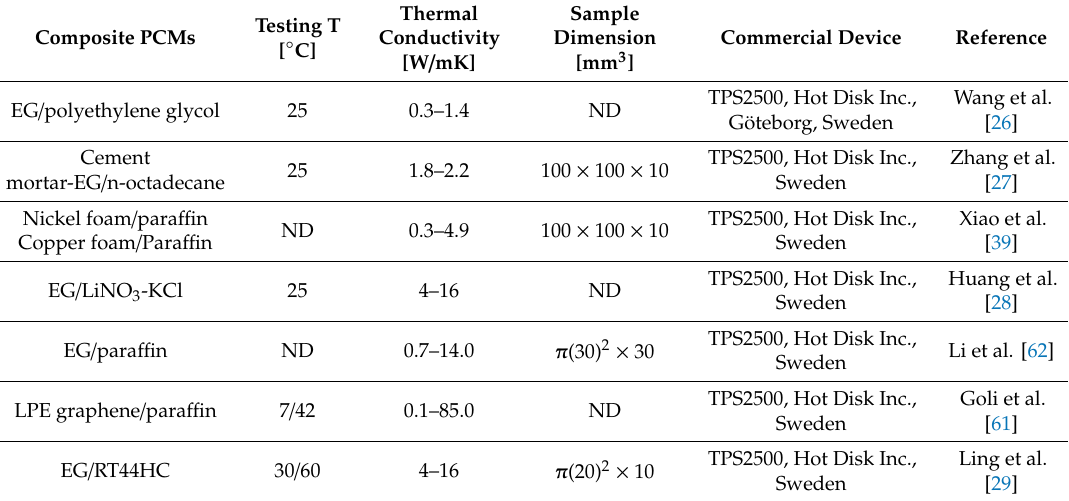
Table 3. Phases, experimental parameters and literature sources for transient plane heat source tests on